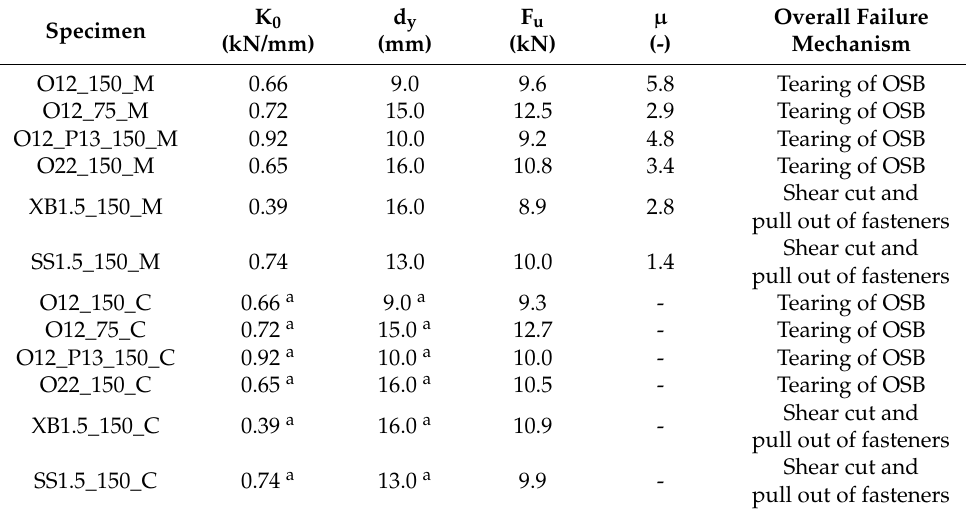
Table 3. Experimental results obtained with testing of LSF